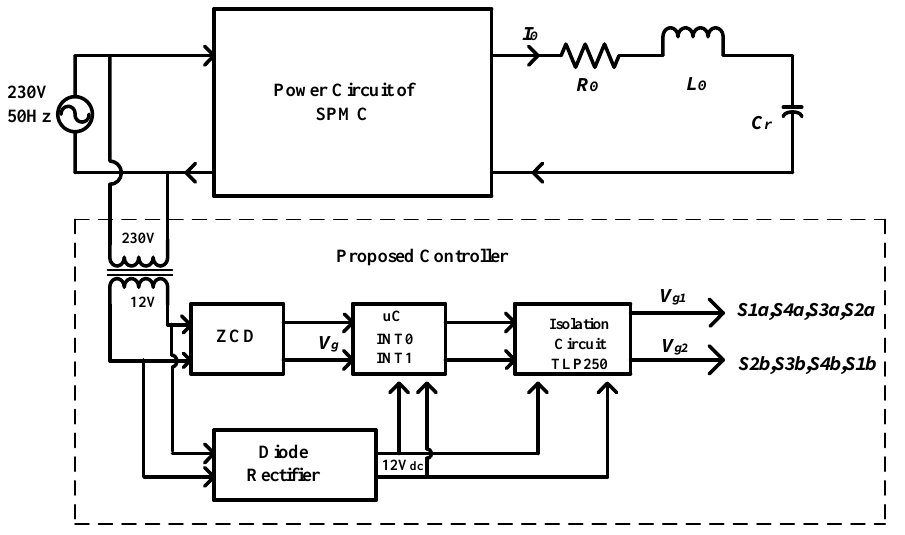
Figure 3. Proposed IH system using SPMC topology incorporated with proposed controller.